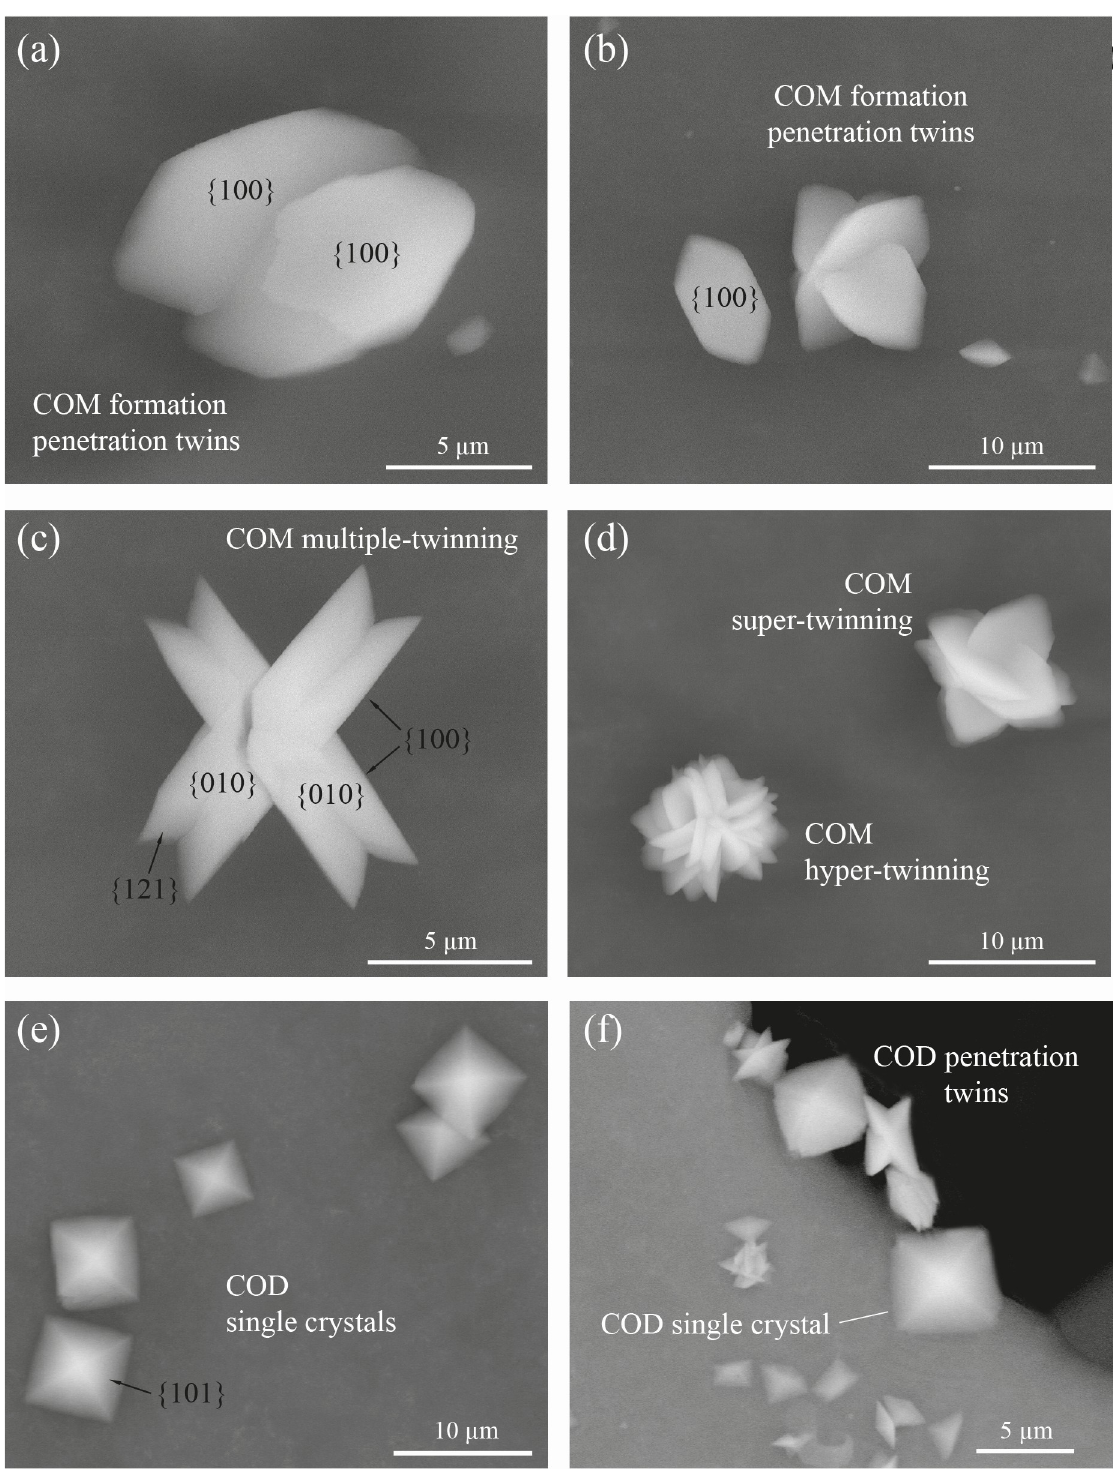
Fig 6. Scanning electron micrographs of various morphological types of COM and COD obtained in the absence (a-d) or presence (e, f) of different concentrations of C . officinarum AE. (a) Twinned COM crystals viewed from a [1] direction. (b) Single and twinned COM crystals. (c) Double-twinned COM crystals viewed a [10] direction. (d) Super- and hyper-twinned COM crystals, forming flower-like aggregates. (e) Single tetragonal bipyramidal COD crystal in the presence of 500 μ g dw/ml AE; (f) Single, tetragonal COD crystals and small penetration twins of flat COD crystals in the presence of 1000 μ g dw/ml